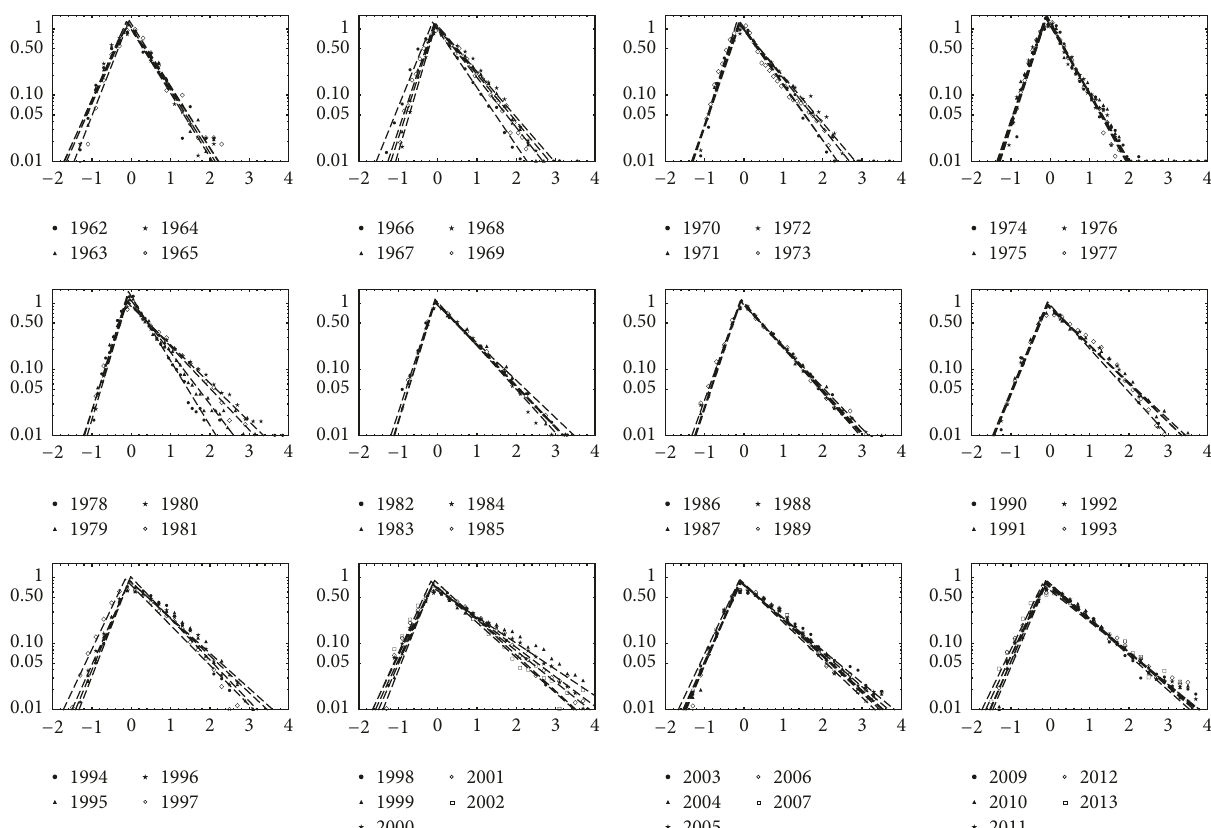
Figure 1: Stacked empirical densities of centered 𝑧 on a log probability scale, 1962–2014, with maximum likelihood fitted asymmetric Laplace distributions (dashed lines). Source: Scharfernaker and dos Santos